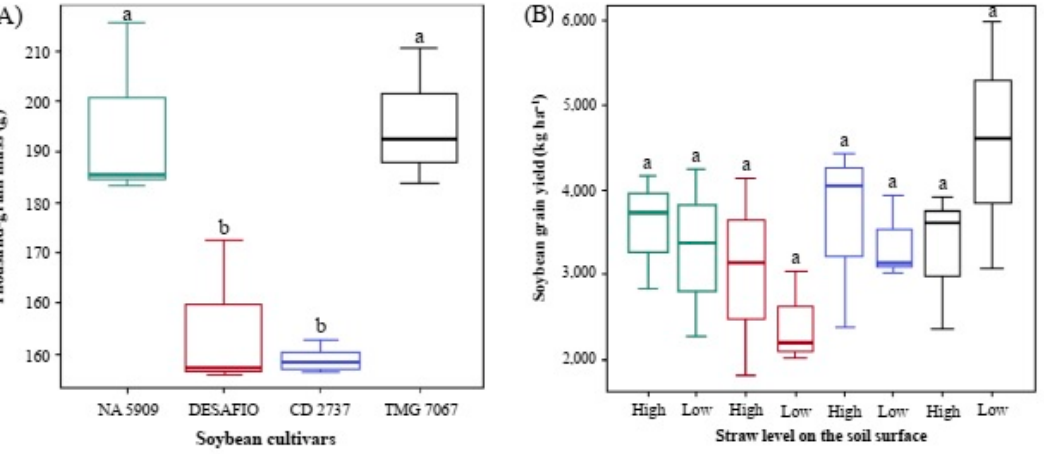
Figure 6. Thousand ‐ grain mass ( A ) and grain yield ( B ) of the four soybean cultivars grown in clayey soil in the Brazilian Cerrado under a no ‐ tillage system with high (6000 kg ha –1 ) and low (1600 kg ha – 1 ) levels of ruzigrass straw on the soil surface. Green, red, blue, and black boxplots represent soybean cultivars NA 5909 RG, BMX DESAFIO RR, CD 2737 RR, and TMG 7067 IPRO, respectively. Bars followed by distinct letters show significant differences by Tukey’s test ( p < 0.05).